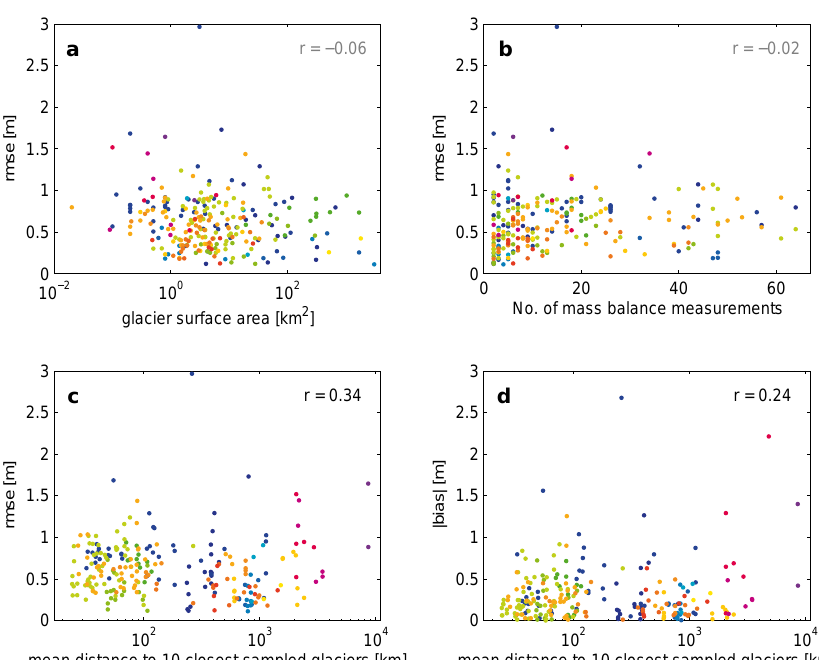
Fig. 12. Cross-validation results; (a) rmse as a function of glacier surface area; (b) rmse as a function of the number of mass balance measurements; (c) rmse as a function of the mean distance to the 10 closest sampled glaciers; (d) magnitude of the model bias as a function of the mean distance to the 10 closest sampled glaciers; numbers indicate correlations (gray/black: below/above 95% confidence